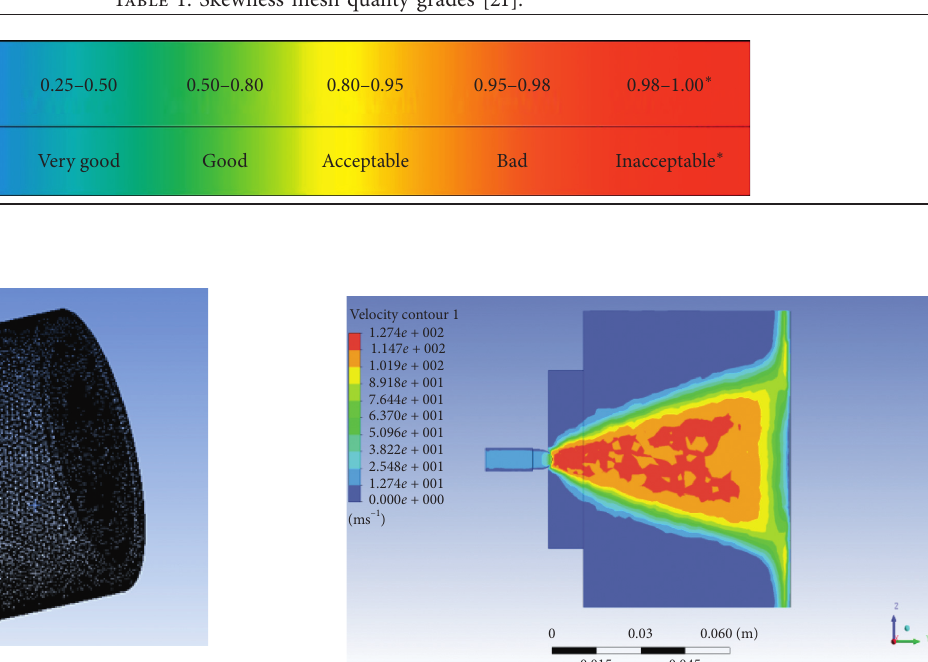
Figure 4: Mesh model of nozzle and external flow field.